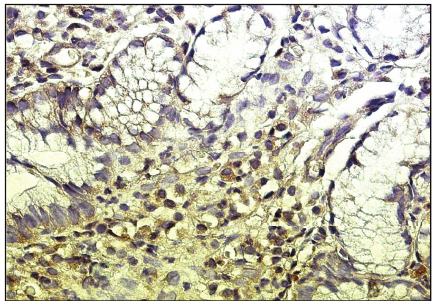
Figure 5: Antrum mucosa in H. pylori -associated gastritis: the iNOS expression by macrophages and lymphocytes of inflammatory infiltrate in lamina propria, magnitude × 400.